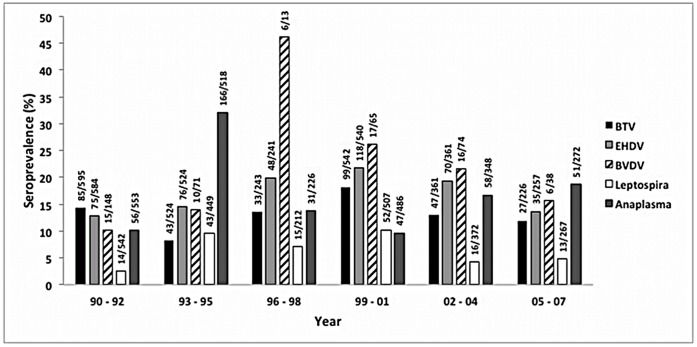
Seroprevalences by three year periods.Seroprevalence of bluetongue viruses (BTV), epizootic hemorrhagic disease viruses (EHDV), bovine viral diarrhea virus (BVDV), Leptospira spp. and Anaplasma spp. among California deer in three year intervals from 1990 to 2007.